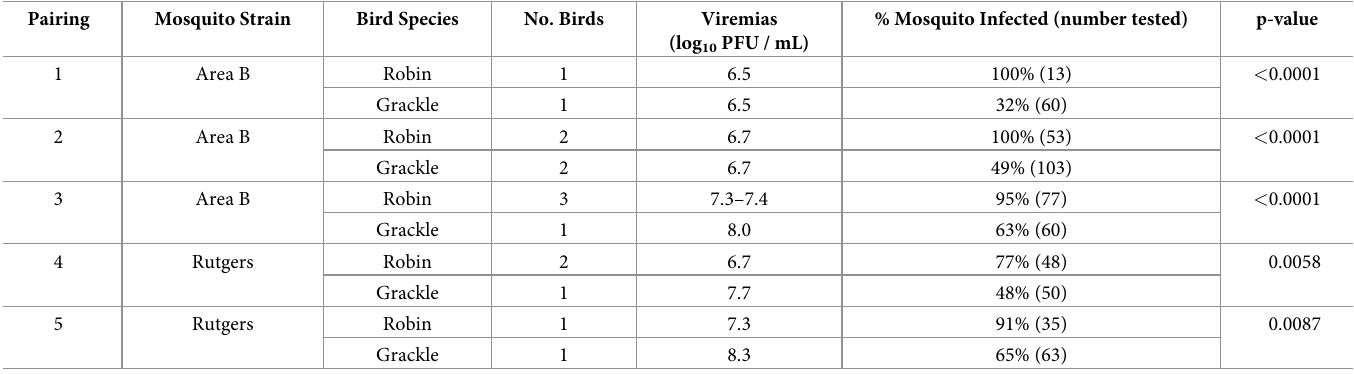
Table 2. West Nile-infected American robins were more infectious to Culex pipiens mosquitoes (both strains) than were common grackles with equivalent or higher viremias. Pairing Mosquito